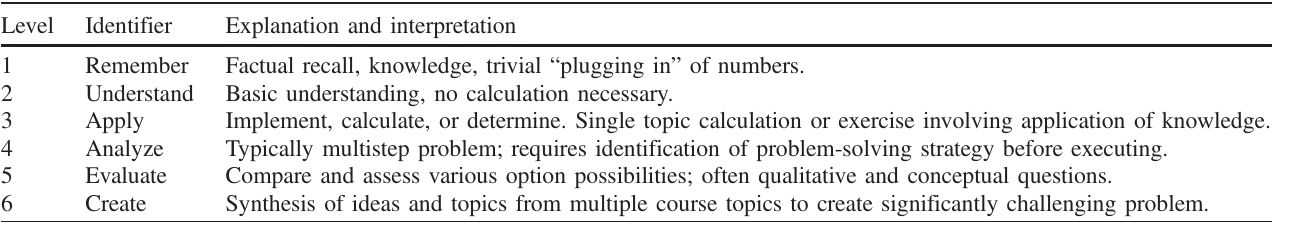
TABLE I. Categorization levels and explanations for the cognitive domain of Bloom ’ s taxonomy.